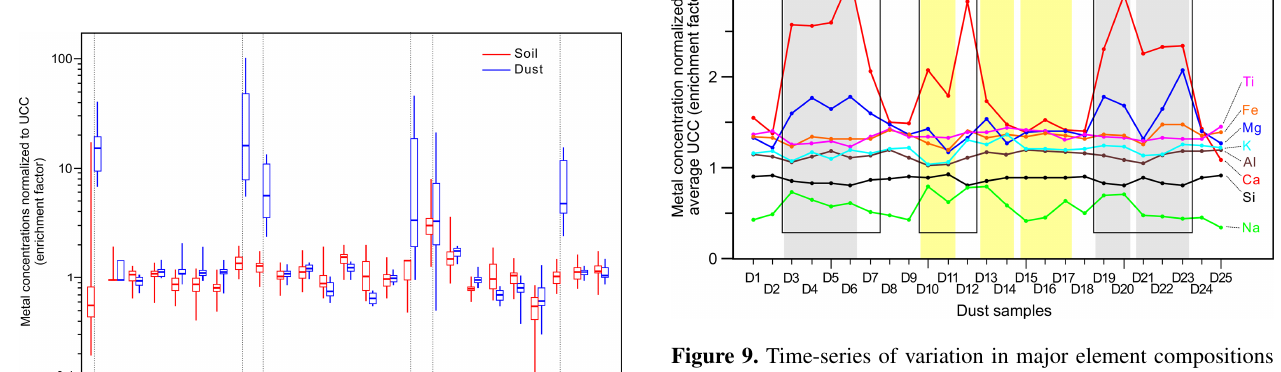
Figure 6. Box and whiskers plot comparing the major element com- positions between Asian dust and source soil samples normalized to the average values of the upper continental crust (UCC) by Rud- nick and Gao (2003). Data for the Taklamakan Desert soils are from Honda et al. (1998; < 45µm) and Jiang and Yang (2019; < 63µm).